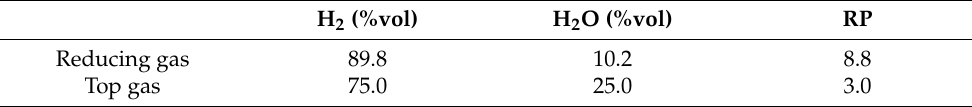
Table 2. Characteristics of the reducing gas and top-gas for the H 2 -DR case.